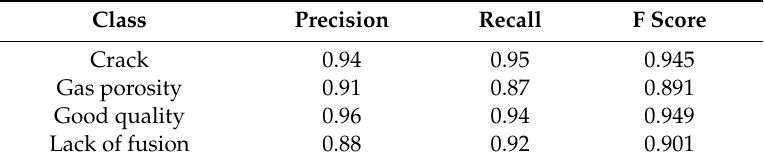
Table 7. Precision, recall, and F score of the final model on the test dataset.